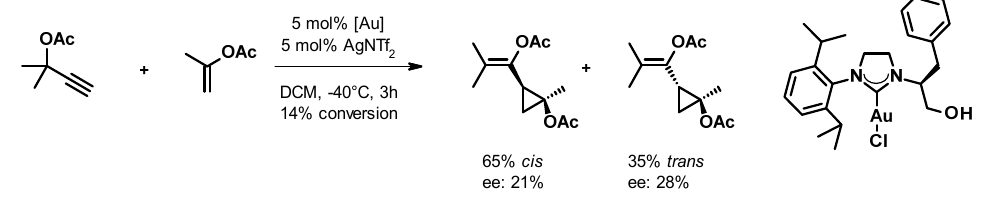
Figure 1. Asymmetric cyclopropanation reaction.